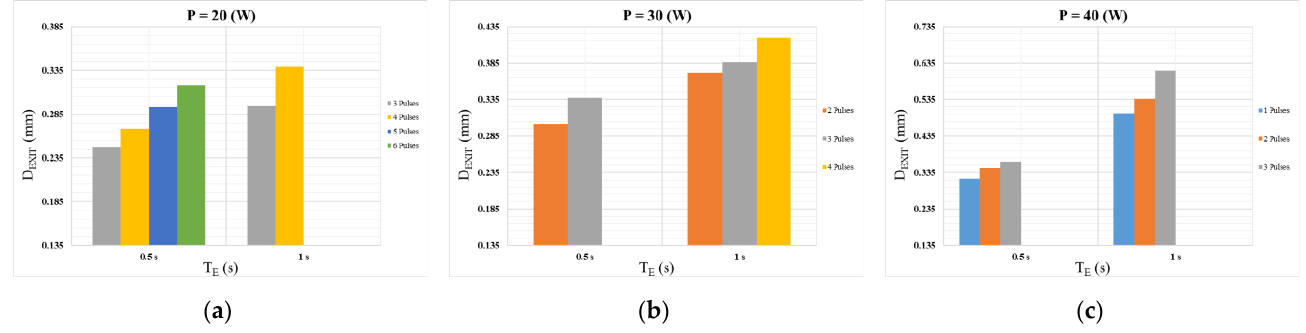
Figure 9. Influence of T E and N P on D EXIT for 0.1 wt.% of CNPs and ( a ) P = 20 W, ( b ) P = 30 W and ( c ) P = 40 W.